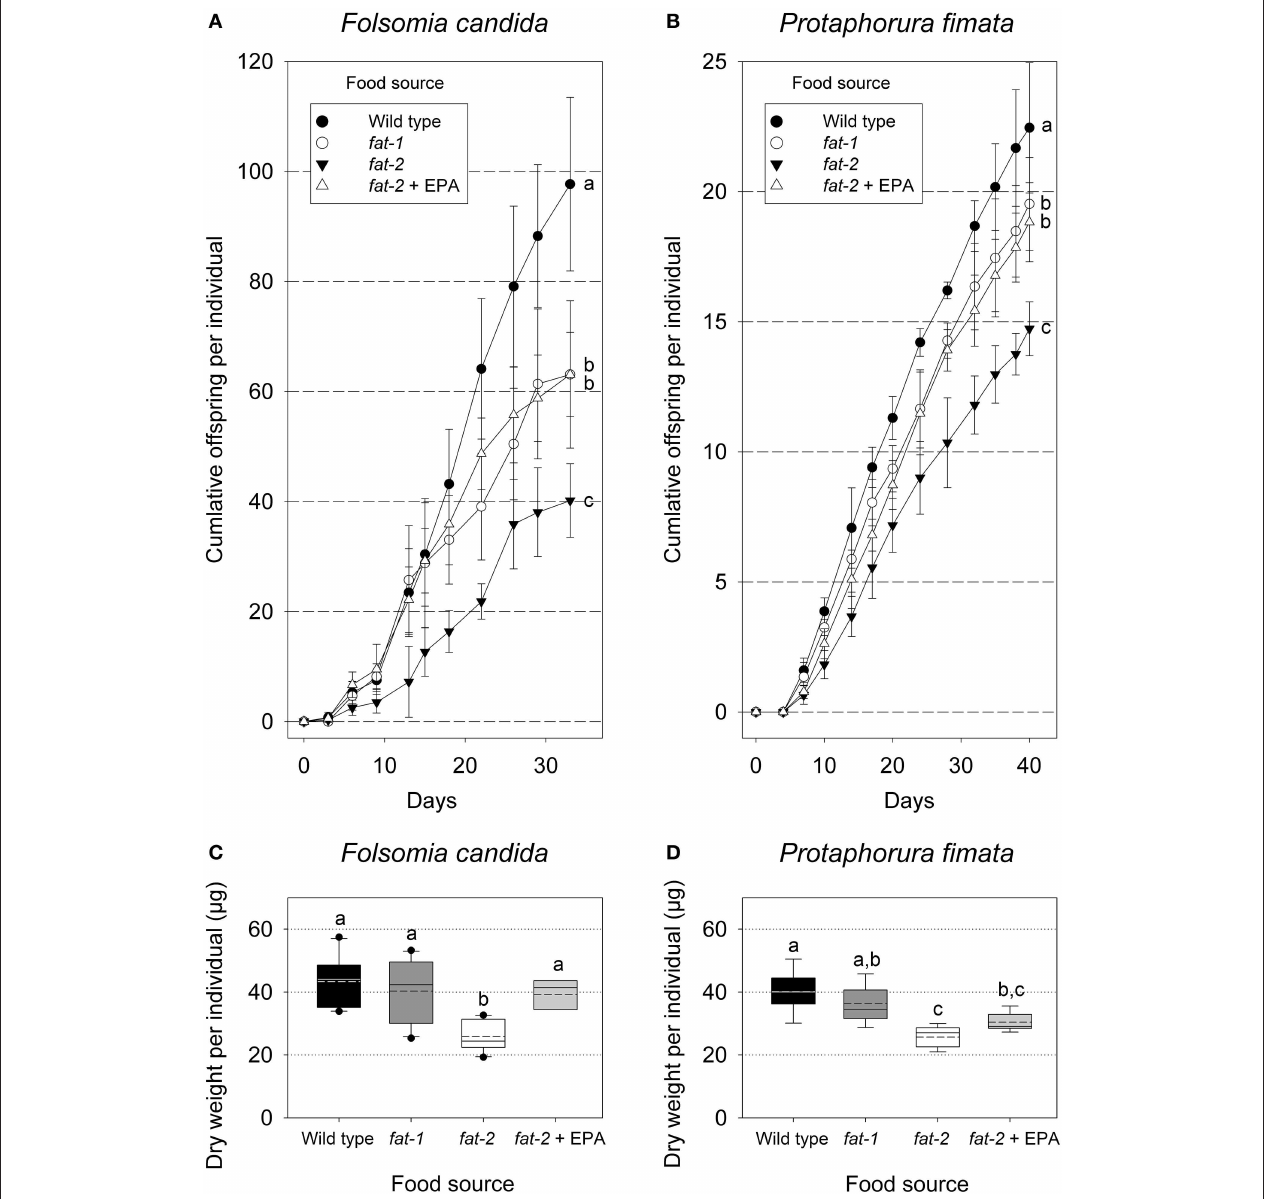
FIGURE 3 | Cumulative numbers of eggs (A,B) and final dry weight per Collembola individual (C,D) of two experimental scenarios: Folsomia candida (A + C) and Protaphorura fimata (B + D), both fed on the four different Caenorhabditis elegans food sources [WT – wild type, fat-1 - no ω 3 LC-PUFAs, fat-2 - no LC-PUFAs, fat-2 + EPA (Eicosapentaenoic acid)]. Bars (A + B) represent standard deviations, box plots (C + D) show each outlier. Statistical differences were tested within each experimental set. Significantly different Bonferroni post-hoc test results ( P < 0.001) are represented by letters, the corresponding F -values are: (A) F (3,16) = 21.15 ( n = 5), (B) F (3,16) = 28.48 ( n = 5), (C) F (3,32) = 10.06 ( n = 9) (D) F (3,32) = 16.66 ( n = 9). Matching letters indicate no statistical